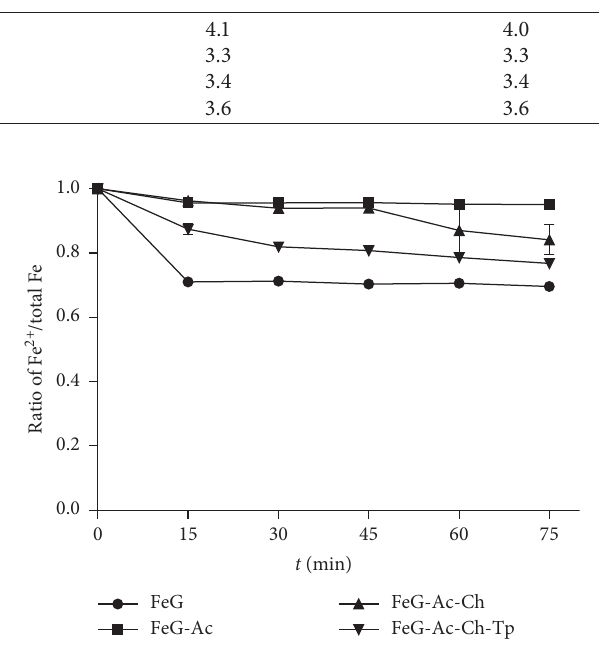
Table 2: Values of anodic peak, and pH of complex solutions containing FeG 10mM, Ac 2.5%, Ch 0.50%, and Tp 0.25% at v � 0.20V/s. Anodic peak pH prior to analysis pH after analysis Current (mA)